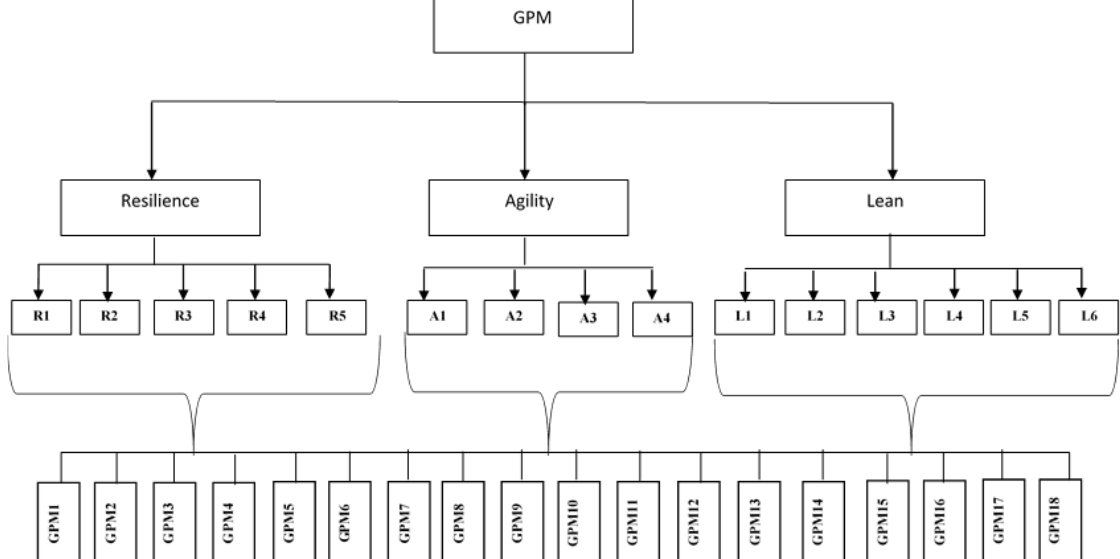
Fig. 2 . Hierarchical tree